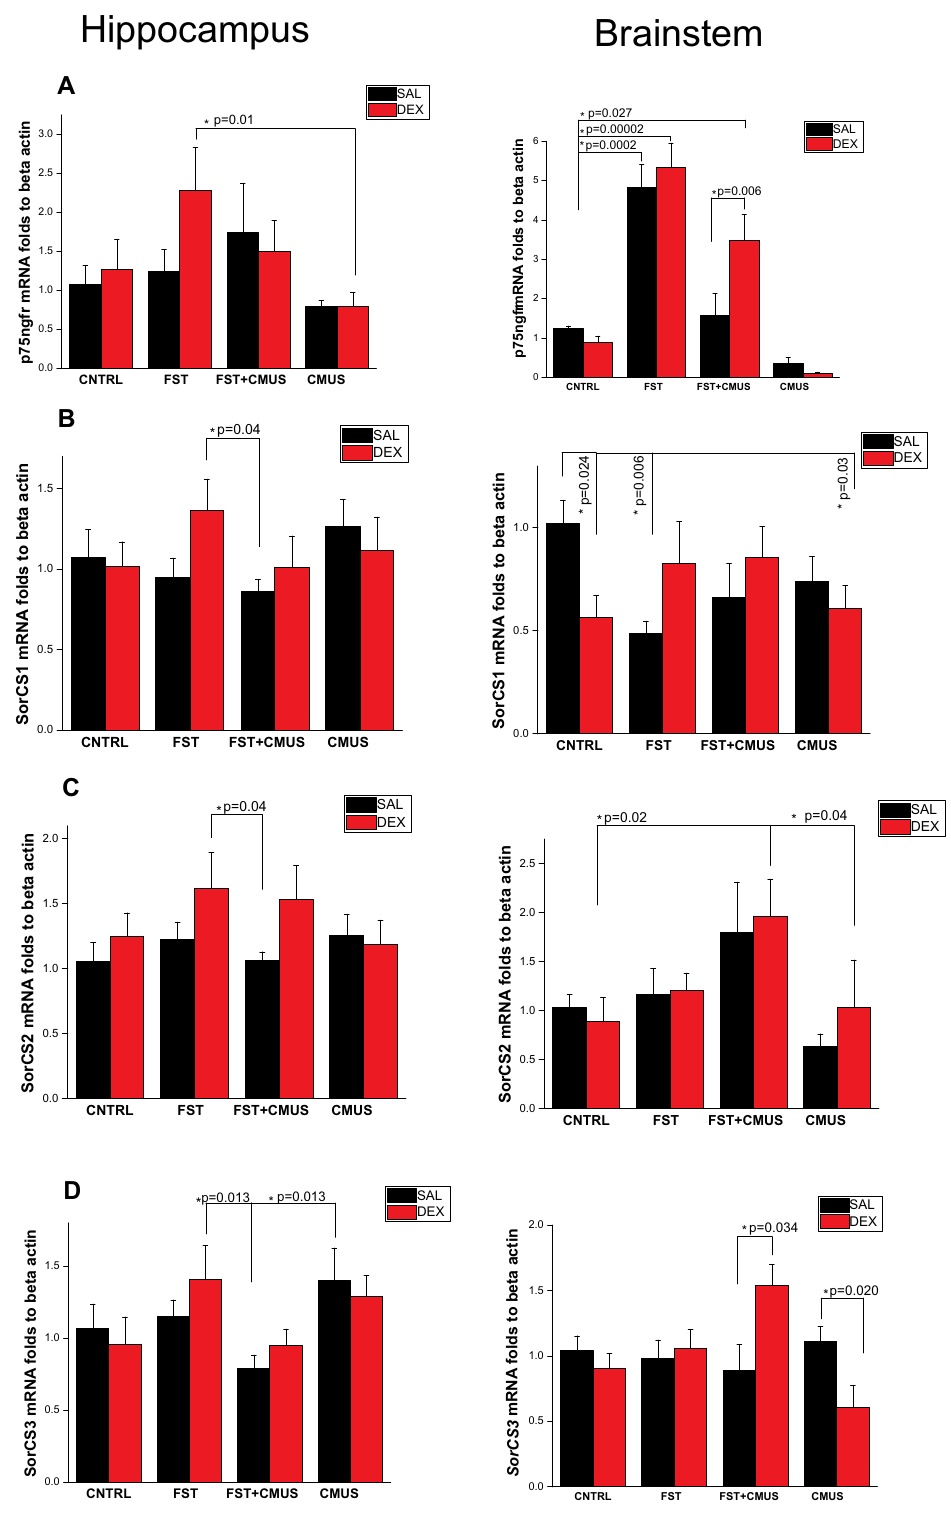
Figure 6. Stress reactive expression of p75ngfr- ( A ) and Sorcs1- ( B ) SorCS2 - ( C ), SorCS3 - ( D ) at P60 in the brainstem after neonatal DEX administration and chronic mild stress (CMUS) at the end of adolescence. TWO WAY ANOVA * p < 0.05, Data are presented as M ±